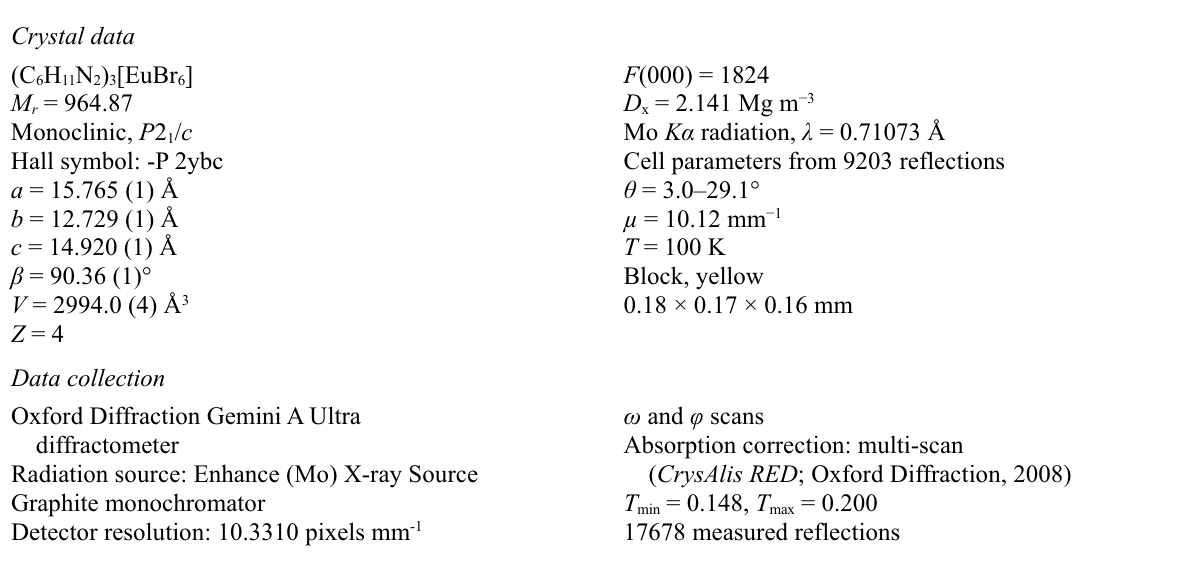
Packing of the structure of [EMIM] face-centers of the monoclinic unit